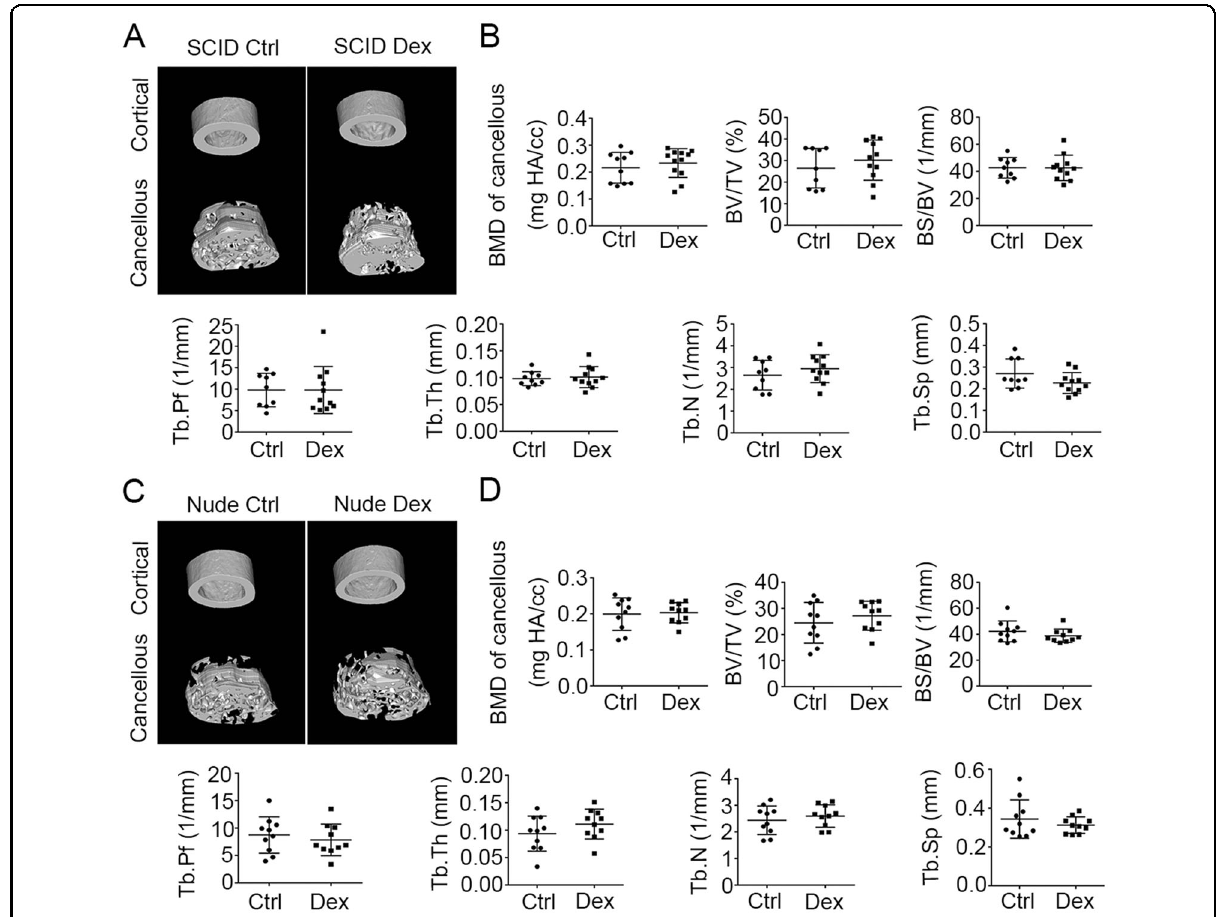
Fig. 2 Mice lacking T cells are resistant to dexamethasone-induced osteoporosis. Micro-CT analysis of femoral bones from SCID and nude mice (13 – 14-week-old females) treated with or without Dex (4 weeks of subcutaneous injection). A Images of the cortical (top) and cancellous bone (bottom). B Cancellous bone parameters were quantitated and compared (as in Fig. 1) between SCID mice treated with Dex ( n = 11) and untreated controls ( n = 9). C Images of the cortical (top) and cancellous bone (bottom). D Cancellous bone parameters were quantitated and compared between nude mice treated with Dex ( n = 11) and untreated controls ( n = 10). Bars represent mean ±